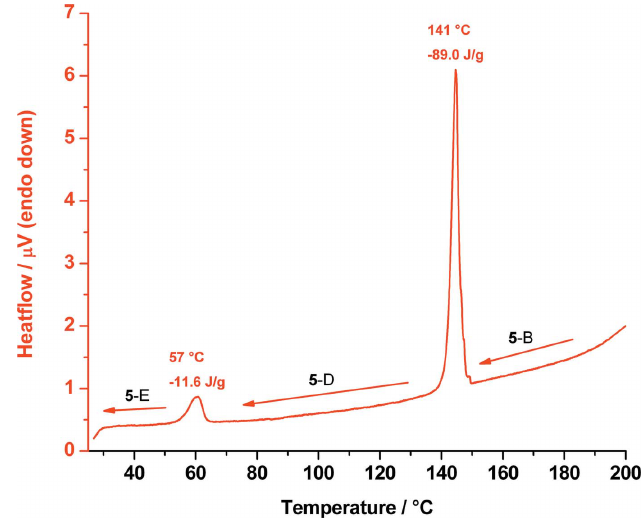
Figure 9 DSC trace of cis -inositol measured from 200 (cid:2) C down to room temperature showing the phase transition of polymorph 5 -B to 5 -D at 141 (cid:2) C and 5 -D to 5 -E at 57 (cid:2)